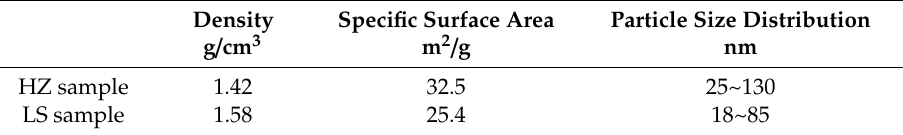
Table 1. Main properties of the sludge samples